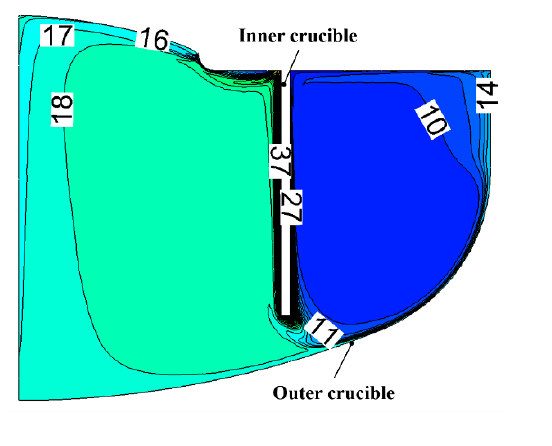
Figure 5. The O distribution (ppma) in the melt: ( a ) there is no oxygen dissolved into the melt from the outer crucible and the inner crucible is the unique source of oxygen impurities, ( b ) there is no oxygen dissolved into the melt from the inner crucible and the outer crucible is the unique source of oxygen impurities.